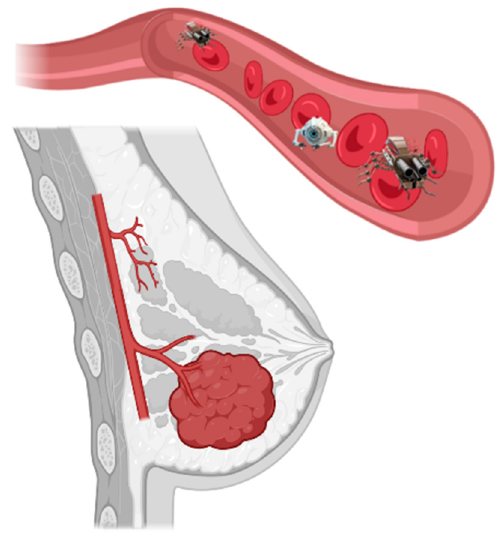
Figure 10. Illustration of possible application of Kv10.1-controlled nanorobots in breast cancer detection and treatment. The cancerous area will be reached by the nanorobots through the blood vessel system. Created with BioRender.